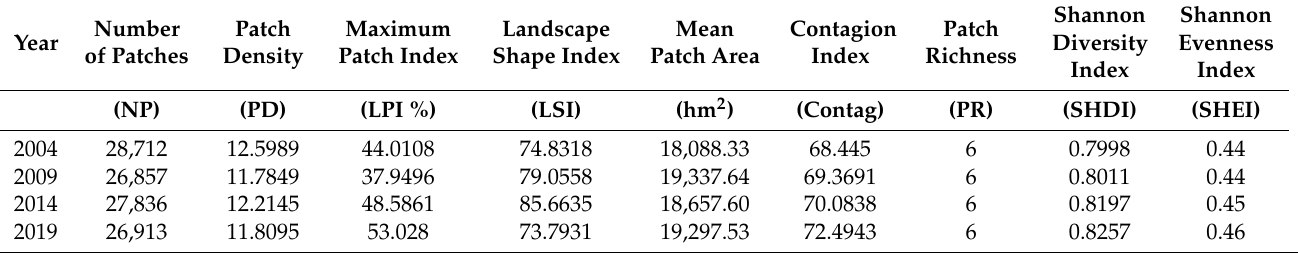
Table 7. Aggregate changes on LULC in Long County during the 15 years (2004–2019), based on different landscape metrics. Number Year of